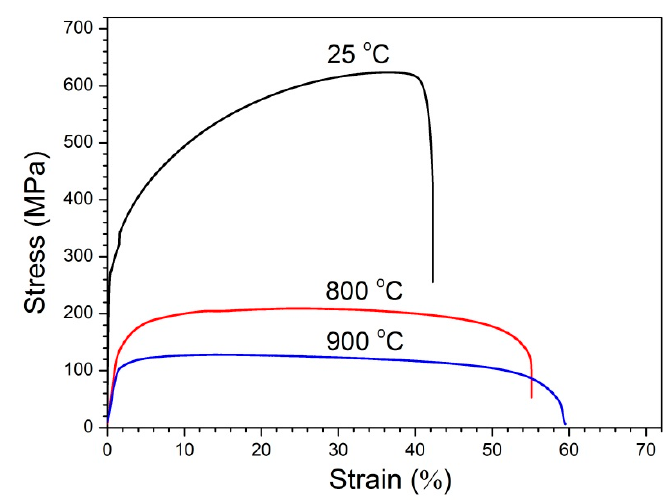
Figure 3. Typical tensile stress–strain curves of 309 SS at different temperatures.